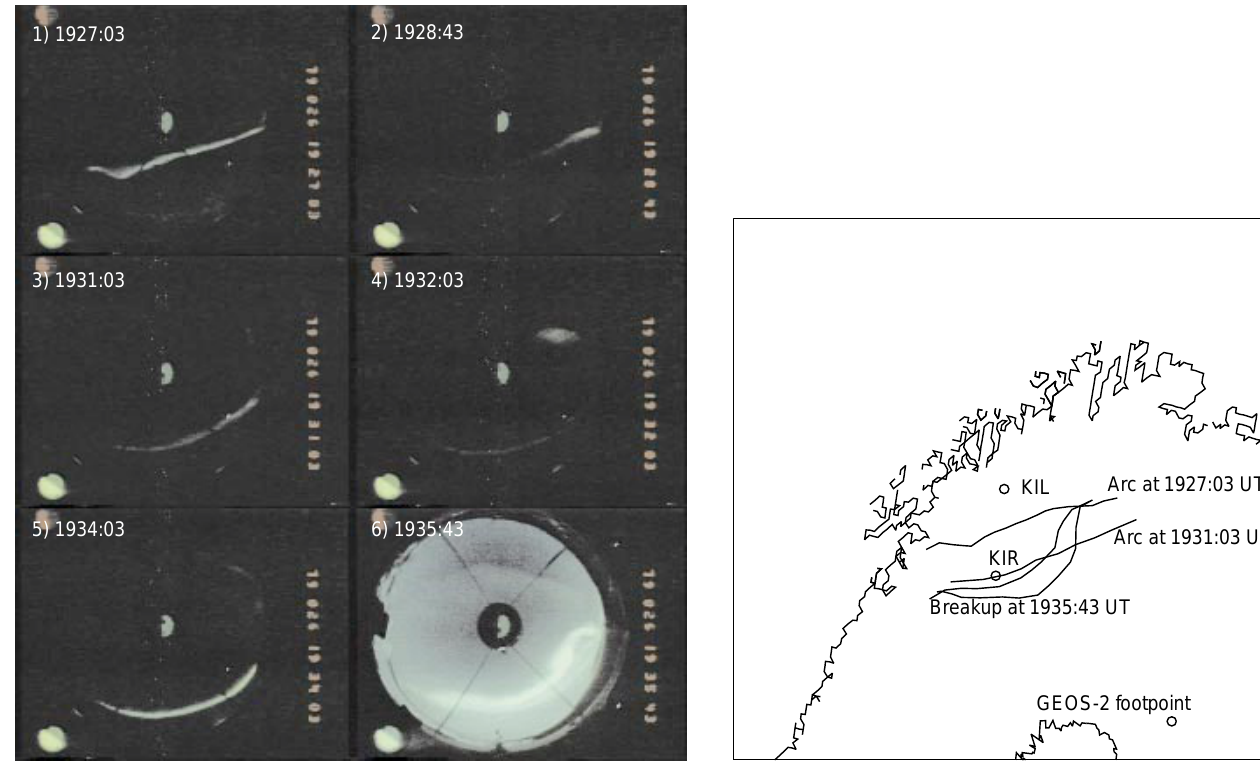
Fig. 3. Fading event on 26 January 1979: ( left ) Six ASC frames from KIL, and ( right ) the approximate locations of the auroral arc on the map of northern Scandinavia (The jagged line is the Norwegian-Russian coast line) at two times before the fadings and at the time of the